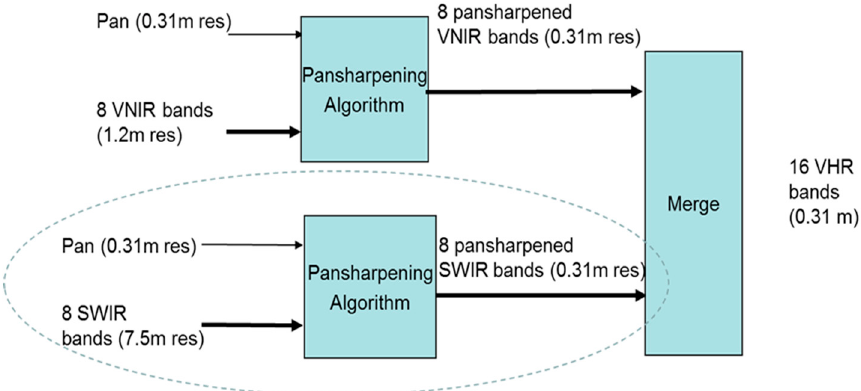
Figure 11. Approach 1: Parallel one-step approach to generating HR VNIR and SWIR bands.